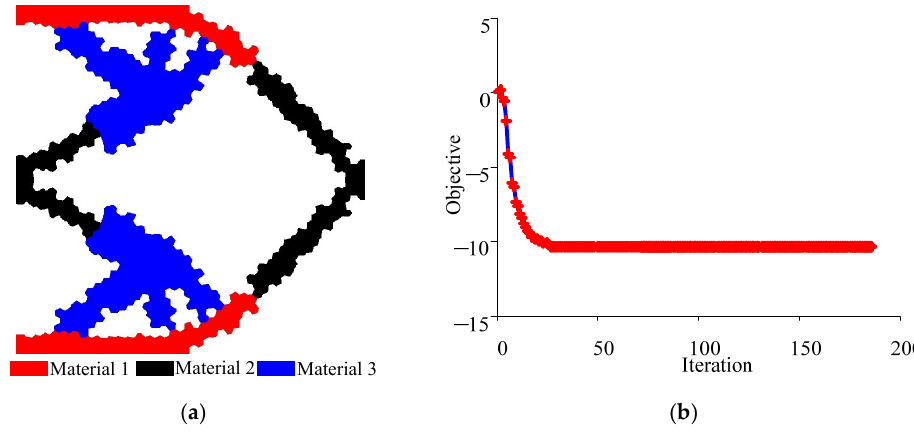
Figure 8. Optimization results of case 4: ( a ) Identifed topologies; ( b ) convergence plot.